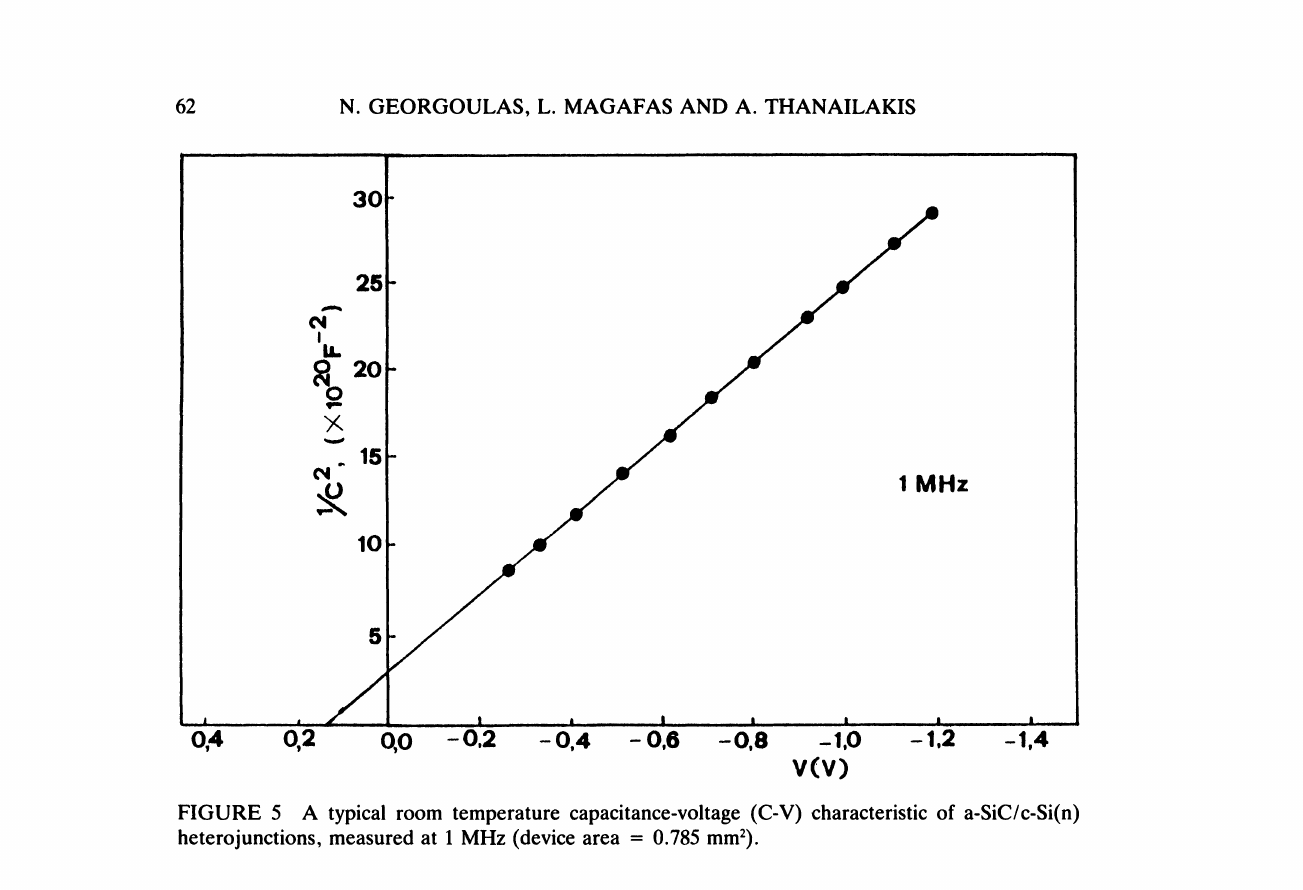
FIGURE 5 A typical room temperature capacitance-voltage (C-V) characteristic of a-SiC/c-Si(n) heterojunctions, measured at MHz (device area 0.785